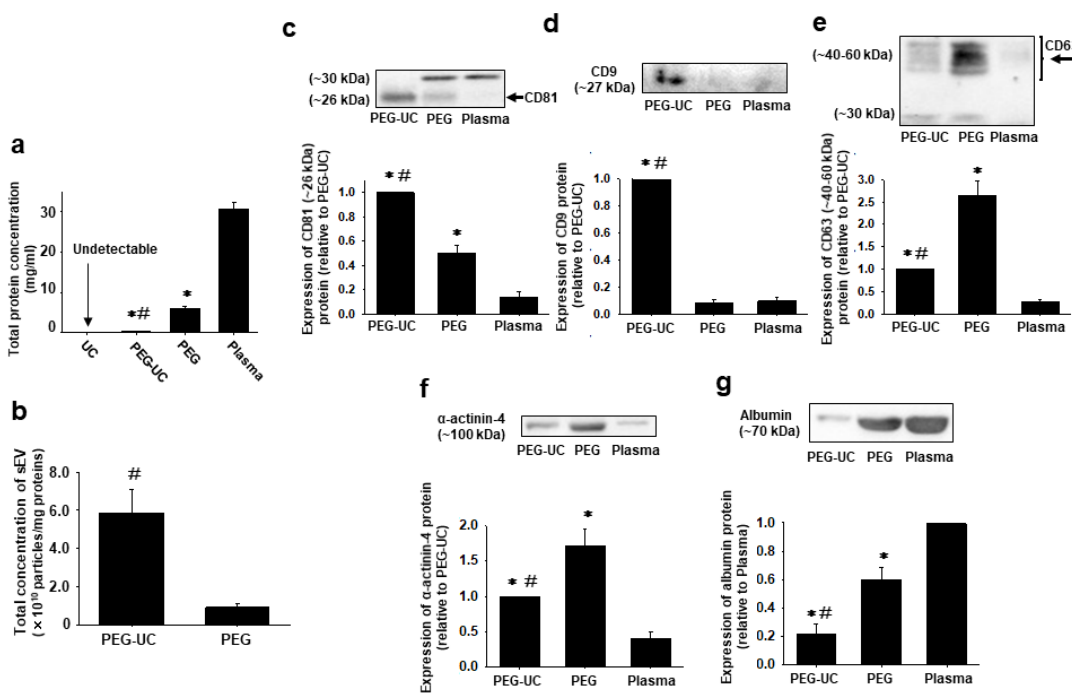
Figure 3. Total protein concentration and expression of marker proteins for sEVs (CD81, CD9, and CD63), large EVs ( α -actinin-4), or plasma (albumin) in sEVs isolated by the di ff erent methods as described in Figure 1. Total protein was extracted from plasma sEVs of male Wistar rats (7–9-week-old) using radio-immunoprecipitation assay (RIPA) bu ff er. ( a ) The concentration of proteins was measured by a bicinchoninic acid (BCA) assay and normalized to the starting volume of plasma (mg / mL). ( b ) The total concentration of plasma sEVs normalized to each protein concentration was shown (particles / mg). ( c – g ) Expression of marker proteins in plasma sEVs was determined by Western blotting using an antibody to CD81, CD9, CD63, α -actinin-4, or albumin. The arrows indicated the bands for CD81 (c) and CD63 (e) that we measured for quantitative analyses. Data were shown as fold increase relative to the expression level in sEVs isolated by the PEG-UC method (c: CD81, d: CD9, e: CD63, f: α -actinin-4) or plasma (g: albumin). Results were expressed as means ± SEM in bar graphs ( n = 4). Uncropped images are shown in Supplementary Figure S2. * p < 0.05 vs. plasma, # p < 0.05 vs. PEG.